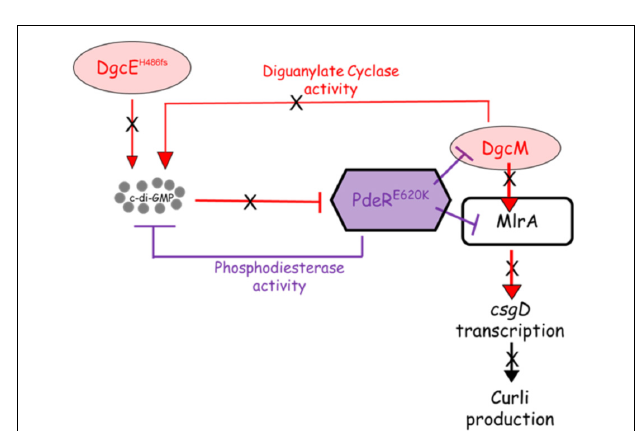
FIGURE 9 | Proposed model for curli inhibition in some of the soil-persistent Escherichia coli . The mutated diguanylate cyclase DgcE (H486fs) in the curli-negative strains is predicted to be unable to produce sufficient cyclic di-GMP (c-di-GMP) to relieve the inhibition of MlrA-DgcM by mutated phosphodiesterase PdeR (E620K). In this state, the mutated PdeR is not able to sense c-di-GMP and thus retains the inhibition of DgcM and MlrA. This renders DgcM unable to act as transcriptional regulator to interact with MlrA and as a DGC to add to the local c-di-GMP pool, thereby inhibiting csgD transcription and curli